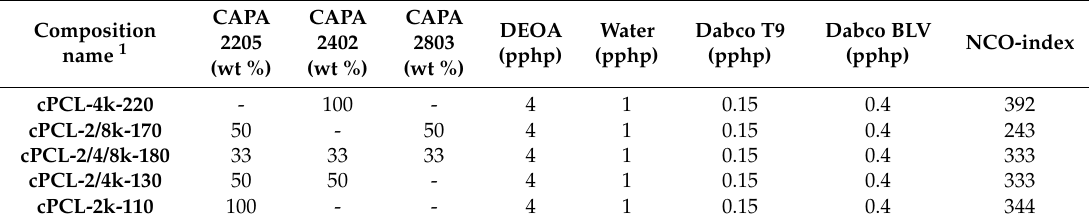
Table 2. Compositions of water-blown PCL-based polyurethane foams. PCL: poly( ε -caprolactone); DEOA: diethanolamine.